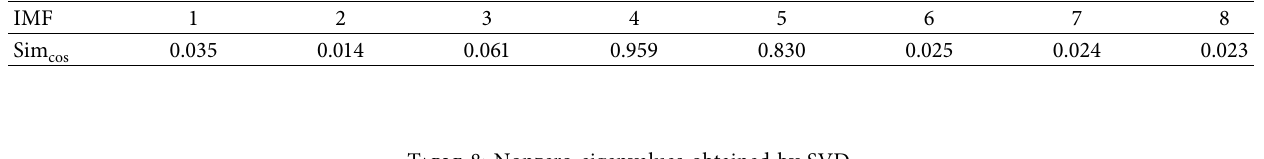
Table 7: Results of cosine similarities based on the second selected raw data.